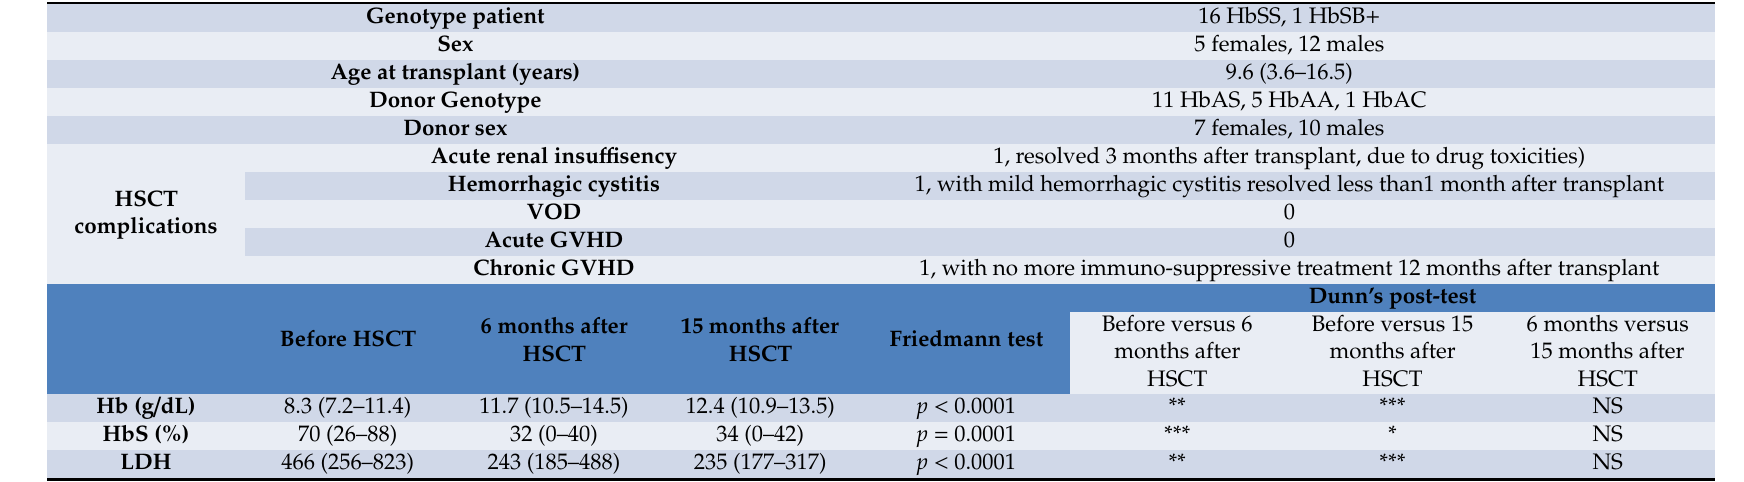
Table 1. Demographic data of the 17 patients, their donors, and clinical and biological data following hematopoietic stem cell transplantation